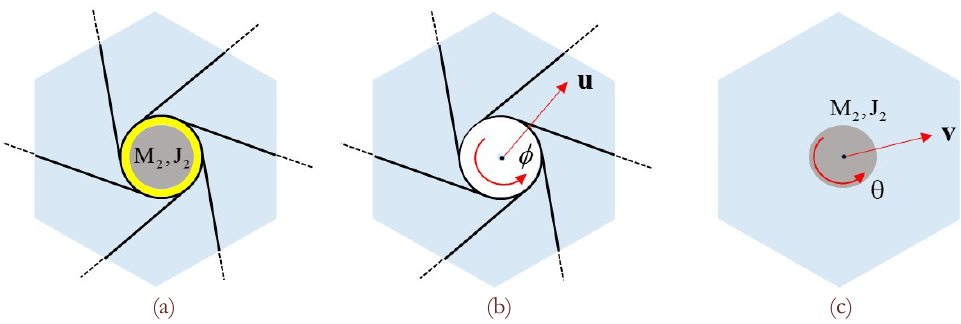
Figure 3: (a) Internal mass with external elastic thick layer; (b) rigid ring and related dofs; (c) internal mass and related dofs.